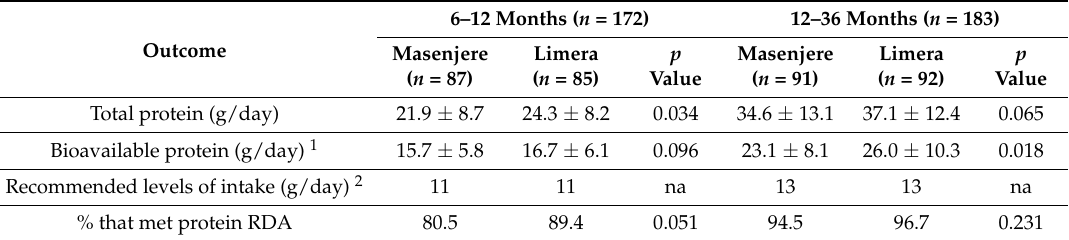
Table 4. Comparison of available protein for digestion in Malawian children aged 6–36 months with the addition of